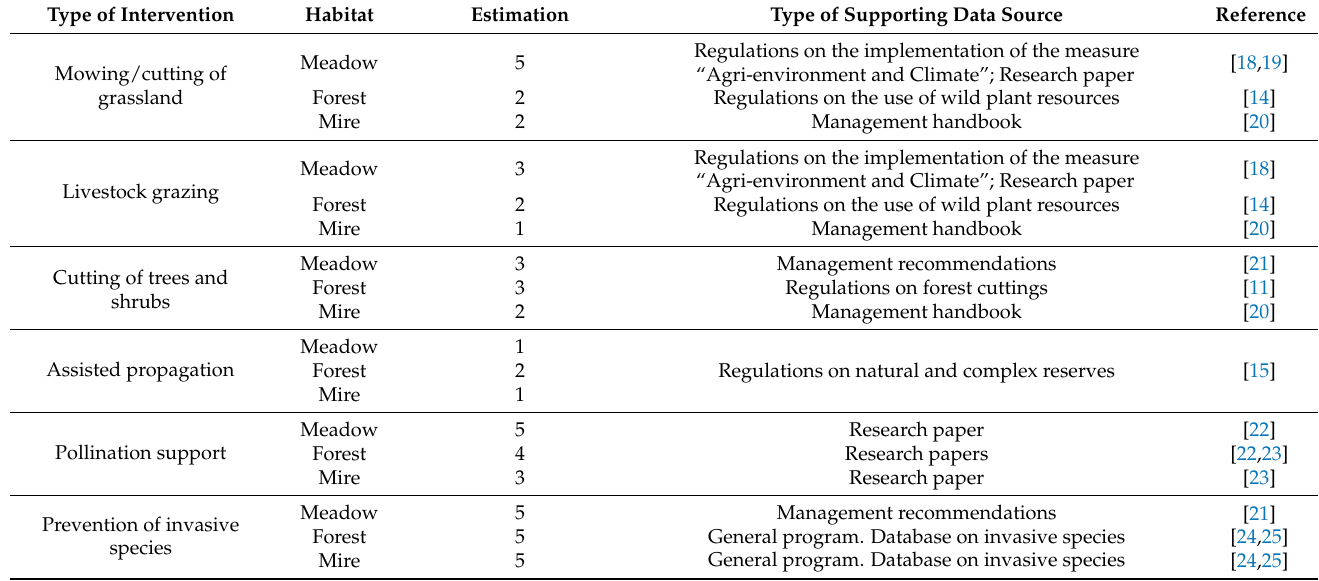
Table 1. Applicability estimation of major genetic reserve site management interventions by habitat type. Estimation scale: 5—very common; 4—common; 3—moderately common; 2—rare; 1—very rare; 0—not applicable. Type of Intervention Mowing/cutting of